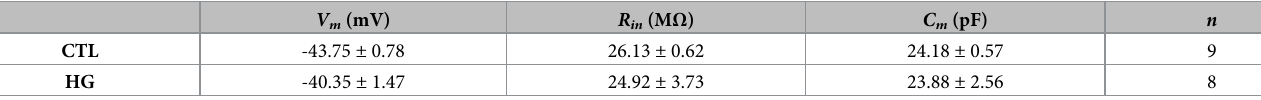
Passive membrane properties for cultured DRG neurons from adult wild type mice. Table summarizes the membrane potential ( V capacitance ( C m ) obtained during whole-cell recording of cultured DRG neurons from adult CGRP- eGFP CD1 mice, maintained in either control or high glucose conditions. Means were compared by unpaired t -test, no significant differences were found between the